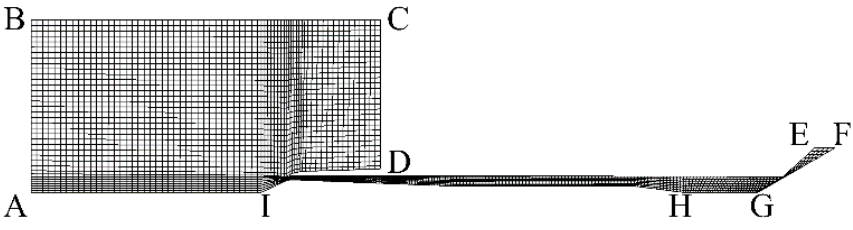
Figure 2. Computational domain and grid.